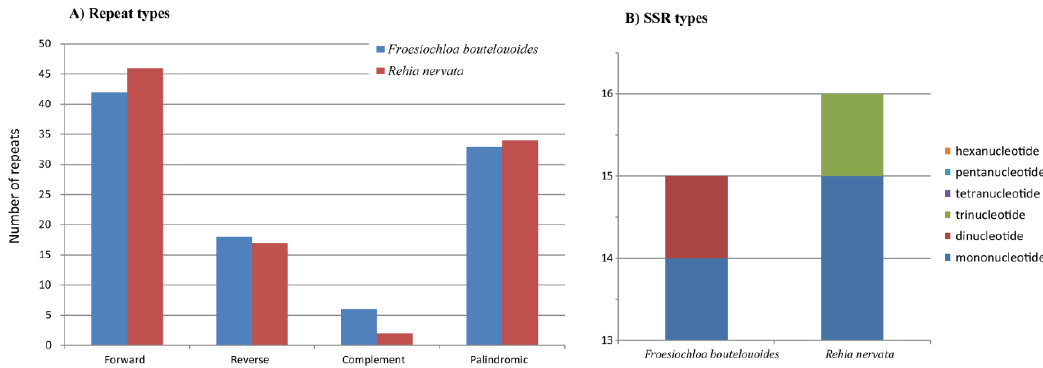
Figure 2. Genome repeat analyses. ( A ) Histogram showing the number of four types of repeat (forward, reverse, complement and palindromic) in the two Olyreae chloroplast genomes. ( B ) SSR unit size distribution in the two chloroplast genomes.